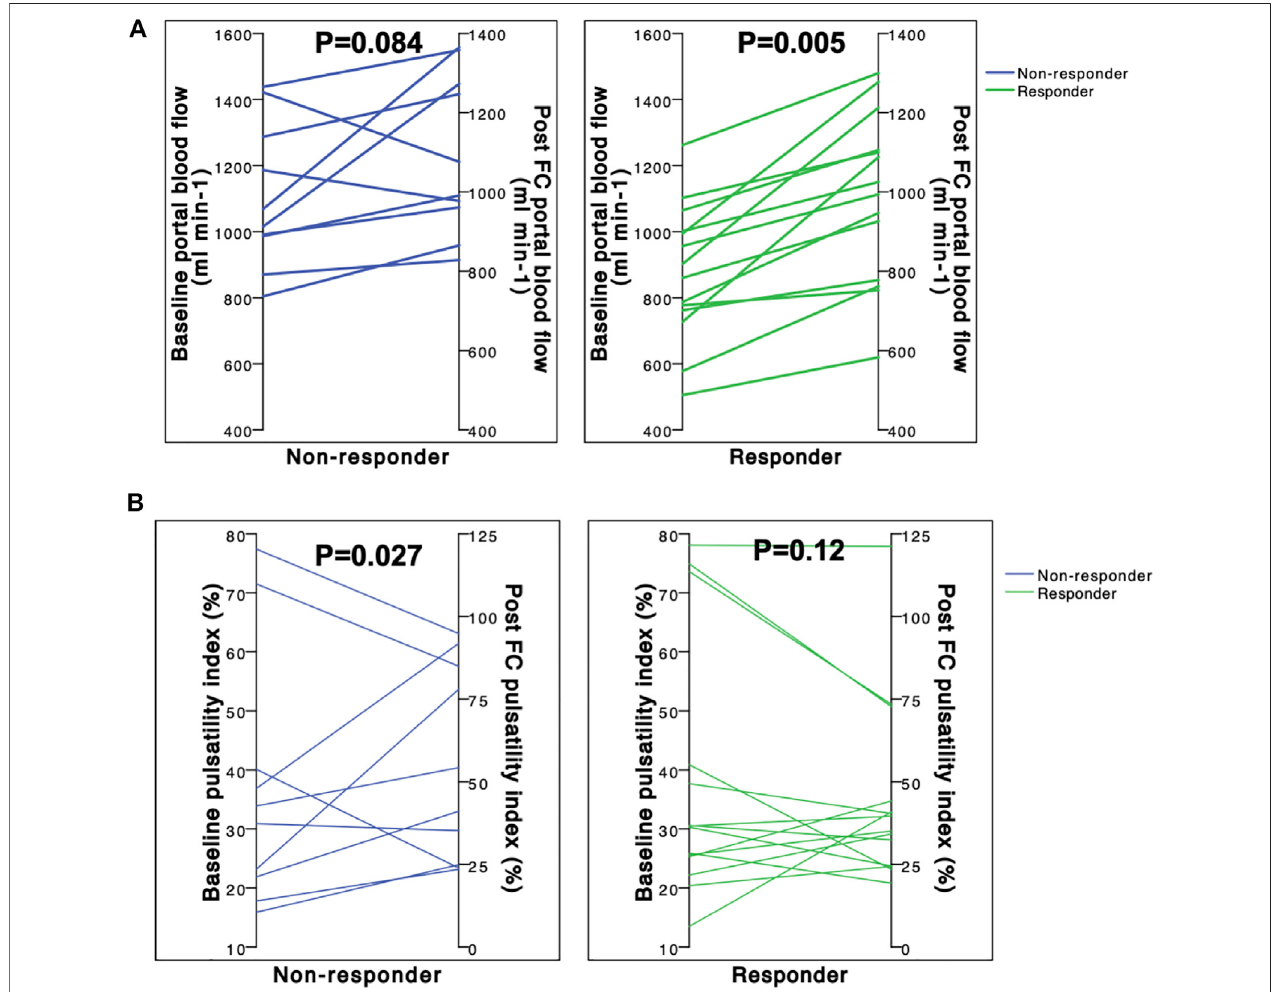
FIGURE 2 | Box plots showing changes in the portal blood fl ow (A) and portal vein pulsatility index (B) at baseline and after fl uid challenge (FC). Fluid responsiveness was de fi ned by a greater than 10% increase in stroke volume. Portal blood fl ow (ml.min − 1) was measured by portal vein MRI. The pulsatility index (%) was calculated as 100 p (maximum portal velocity-minimum portal velocity)/maximum portal velocity. Baseline/post-FC comparisons were performed using a Wilcoxon rank sum test. P: p -value for the statistical